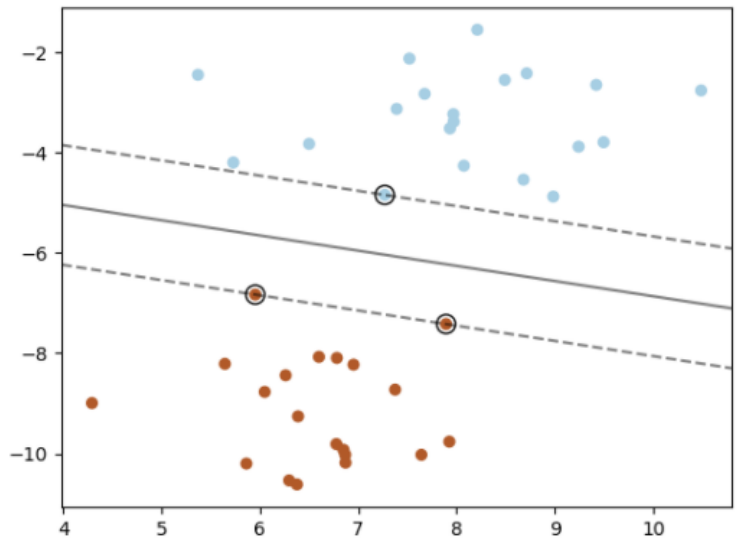
Figure 6. Linearly separable data into two classes (in different colours), with three samples on the margin boundaries (dashed lines) called “support vectors”. The solid line is an optimal hyperplane [21].